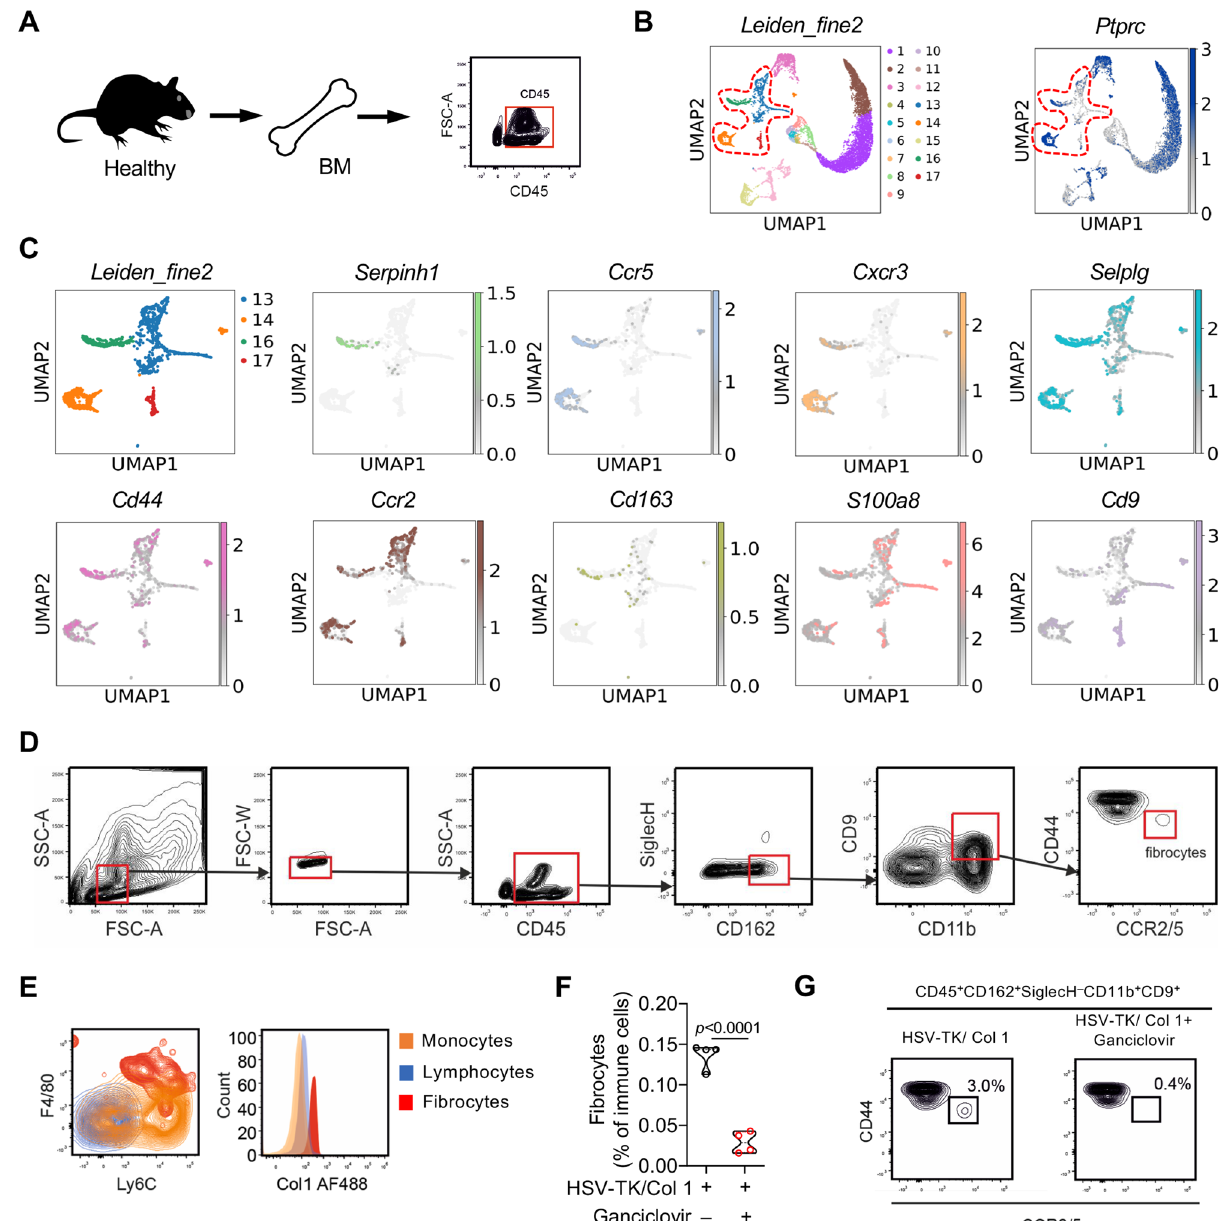
Fig. 1 | Single-cell RNA-seq identi fi es a combination of fi brocyte speci fi c mar- kers. A Schematic diagram of CD45 + cell isolation from the bone marrow of a C57BL/6 mouse. B Uniform manifold approximation and projection (UMAP) representation of the data clustered by the Leiden algorithm revealing 17 clusters (left). Expression of Prprc (CD45) is shown in the panel on the right. C UMAP representation of all cells belonging to cluster 13, 14, 16, and 17 by the Leiden algorithm. Expression of Serpinh1, Ccr5, Cxcr3, Selplg, Cd44, Ccr2, Cd163, S100a8 and Cd9 are shown. D Representative FACS contour plots of fi brocytes (CD45 +